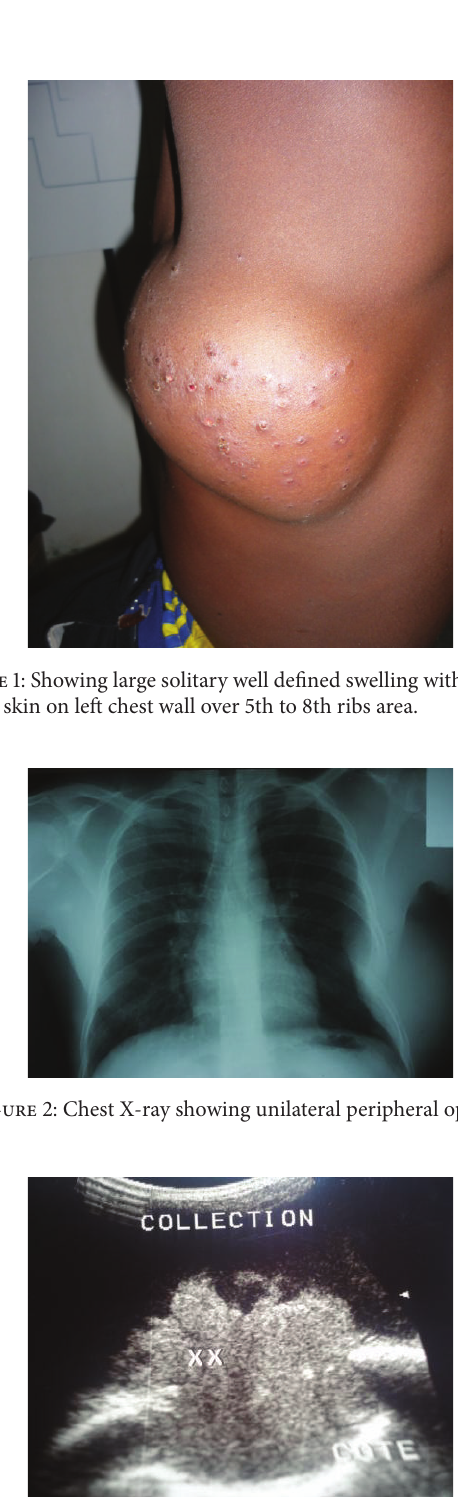
Figure 3: Ultrasonography showing hypoechoic lesion with dense internal echoes and destruction of rib.